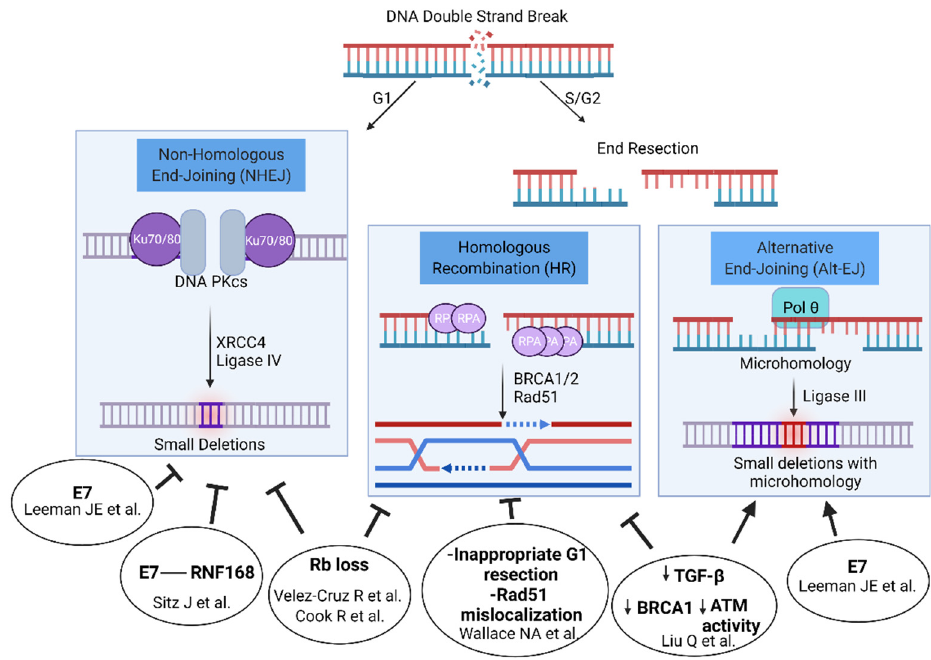
Figure 1. Double-strand break repair pathways and proposed mechanisms of HR-HPV mediated effects on pathway usage. Figure created with Biorender.com.